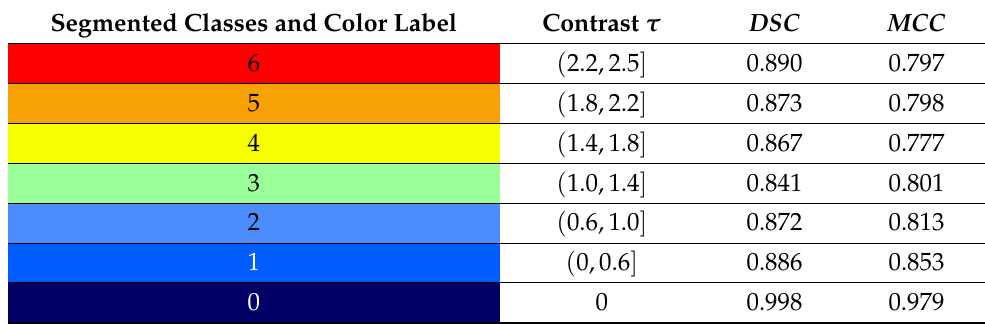
Table 2. Ten-fold cross-validation averaged performance for the different segmentation classes. Segmented Classes and Color